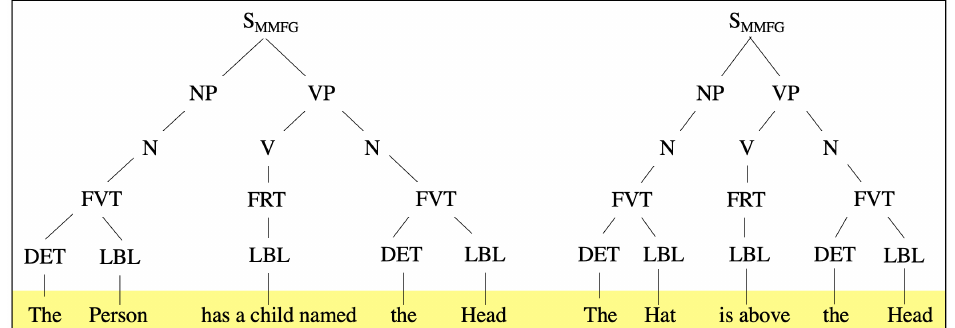
Figure 7. PS-tree with production rules, P ESMMFG , of, G ESMMFG , applied to MMFG ex .